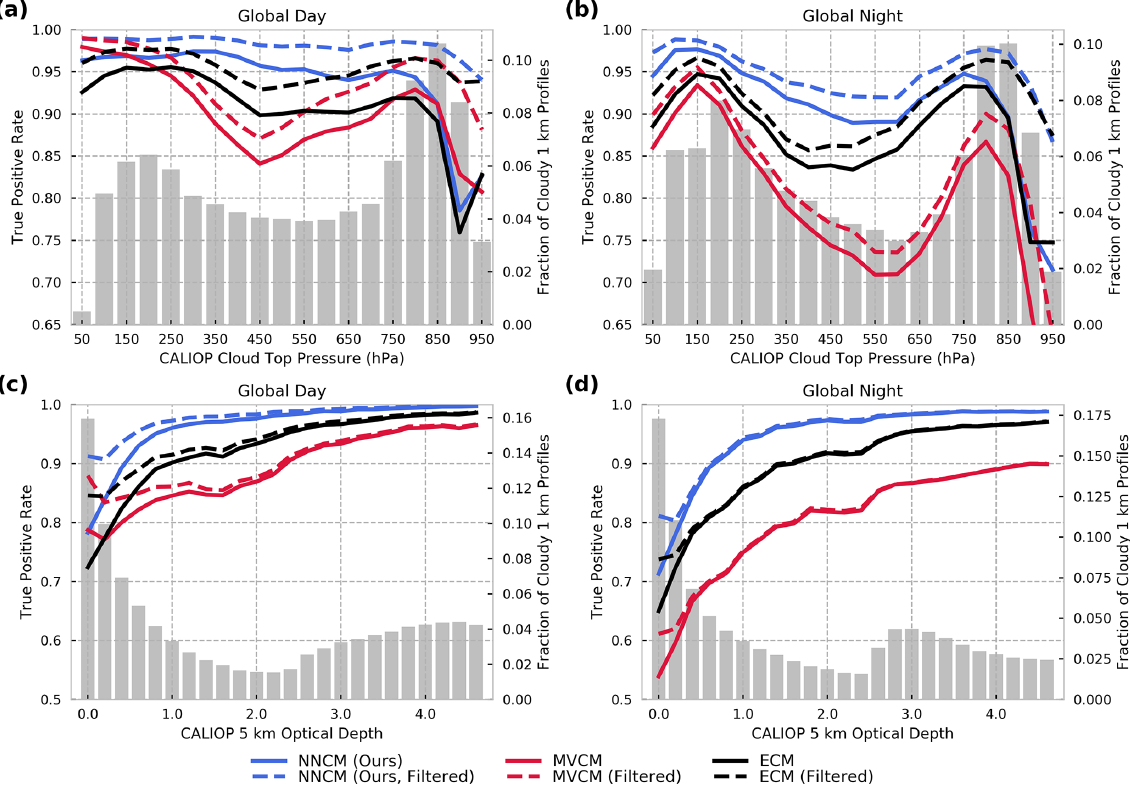
Figure 4. True-positive rate (TPR) calculated as a function of cloud-top pressure (a, b) and optical depth (c, d) for daytime and nighttime collocations, respectively. The gray bars represent the fraction of cloudy 1km CALIOP profiles. Only profiles with non-zero optical depths are included in (c) and (d)